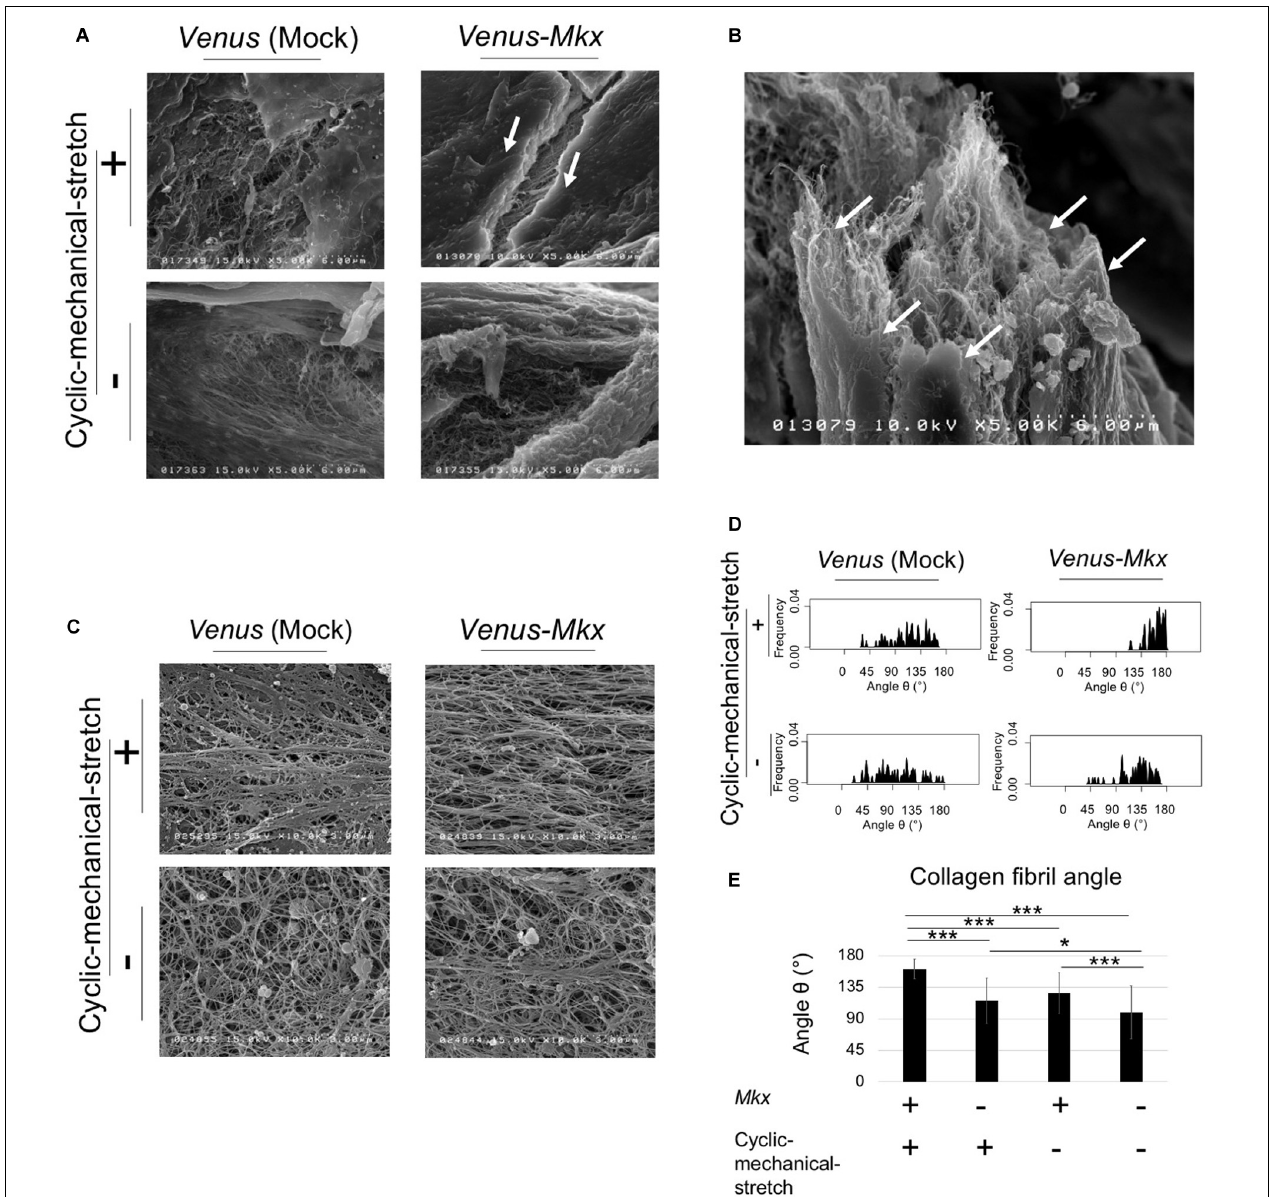
FIGURE 4 | SEM analysis revealed the ultra-structure of surface and fibril arrangement of inner tissue. (A–E) The tendon/ligament-like tissue. These tissues were generated under four different culture conditions: VMS+ (right top), VMS– (right bottom), VS+ (left top), and VS– (left bottom). The direction of the cyclic mechanical stretch load is represented by black arrows. (A) Scanning electron microscopy (SEM) images of the surface layer of tendon/ligament-like tissues. The white arrow shows the surface layer of the tendon/ligament-like tissue obtained from VMS + condition ( n = 3). Scale bar: 6 µ m. (B) SEM image of the section illustrated in panel (A) taken from a different angle. The white arrow shows the surface layer of the tendon/ligament-like tissue. Scale bar: 6 µ m. (C–E) Analysis of collagen fibril arrangement. (C) SEM images of the tendon/ligament-like tissue. (D) Kernel Density Plots of collagen fibril arrangements. Data were calculated from 60 collagen fibrils in three different fields of view. The collagen fibril angle ( θ ) was calculated by comparing the direction of the horizontal axis and the orientation of the collagen fiber axis. (E) Calculated mean collagen fibril arrangement of each sample. The collagen fibril angle ( θ ) was calculated by comparing the direction of the horizontal axis and the orientation of the collagen fiber axis. The mean diameter of 60 collagen fibrils from three different fields of view was calculated: for VMS + condition (right top), mean angle 161 ◦ ; for VMS– condition (right bottom), mean angle 126 ◦ ; VS+ condition (left top), mean angle 115 ◦ ; for VS– condition (left bottom), mean angle 99 ◦ . Error bars show the mean ± standard deviation. An asterisk represents statistical significance calculated by Bonferroni test:* p < 0.05 and *** p < 0.001.